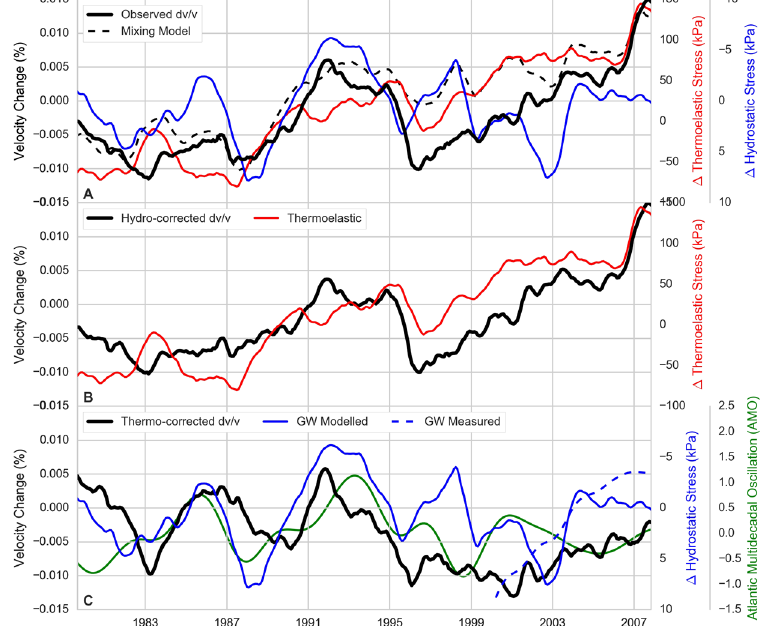
Figure 5. Observed dv/v and results of modeling. ( A ) Observed dv/v (black), modeled dp t (red), modeled dp h (blue) and Mixing model M = 0.5 * α . dp t − 0.5 * ß . dp h (dashed black); ( B ) dv/v + β . dp h (“hydro-corrected dv/v ”, black) and dp t (red). ( C ) dv/v − α . dp t (“thermo-corrected dv/v ”, black), dp h from model (blue) or observed (dashed blue) and Atlantic Multidecadal Oscillation index